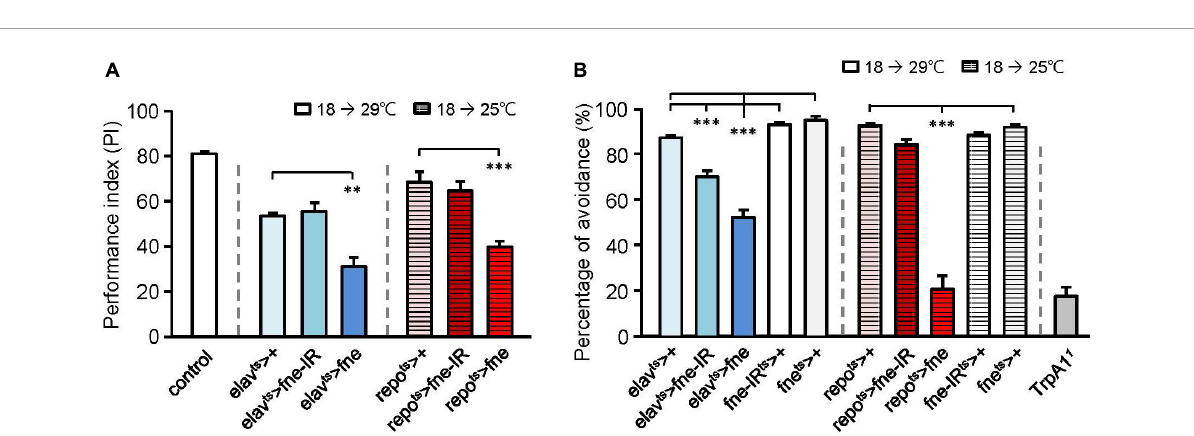
FIGURE2 Effects of fne on cognitive behavior and thermal nociception. (A) The learning PI of fne and fne-IR expressing in neurons and glia. The control fly is 25 ◦ C 5-day-old Canton-S strain for experimental calibration. n = 5–6 for each group. (B) The percentages of avoidance in response to noxious temperature of fne and fne-IR expressing in neurons and glia. The TrpA1 mutant ( TrpA1 1 ) fly is a positive control (25 ◦ C, 5-day-old). n = 10 for each group. Error bars represent SEM. ∗∗ p < 0.01, ∗∗∗ p <